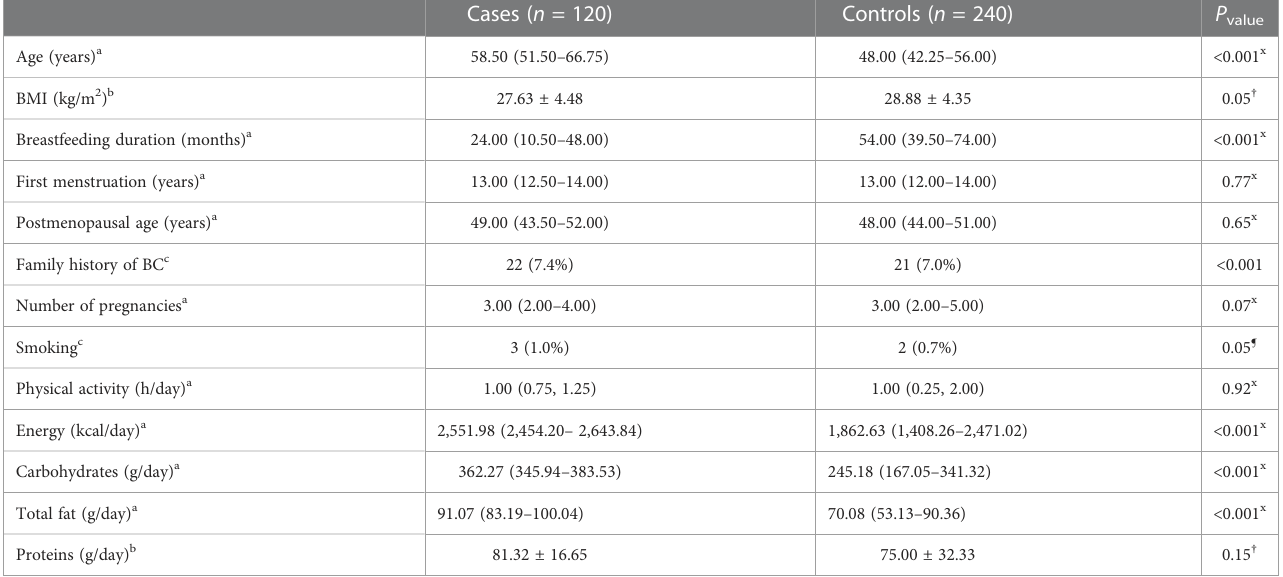
TABLE 1 Characteristics of the study